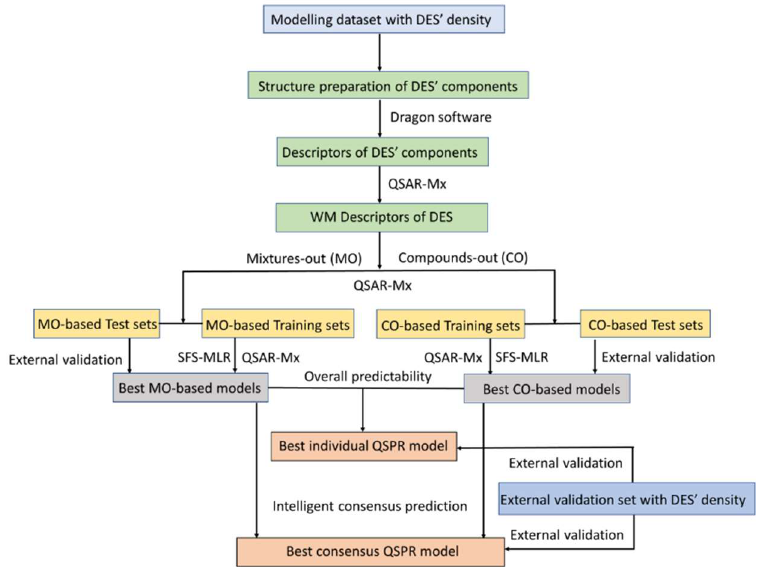
Figure 2. Basic workflow diagram for the QSPR analysis, adopted in this work.